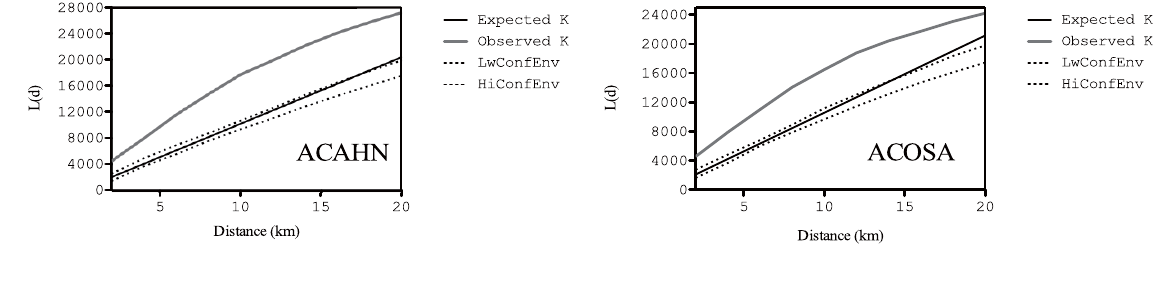
Figure 5. Multi-Distance Spatial Cluster Analysis (Ripley’s K Function) of forest management units for ACAHN (Northern Costa Rica) and ACOSA (Southern Pacific); the other three conservation areas also indicate a high degree of clustering at all spatial scales (Data not